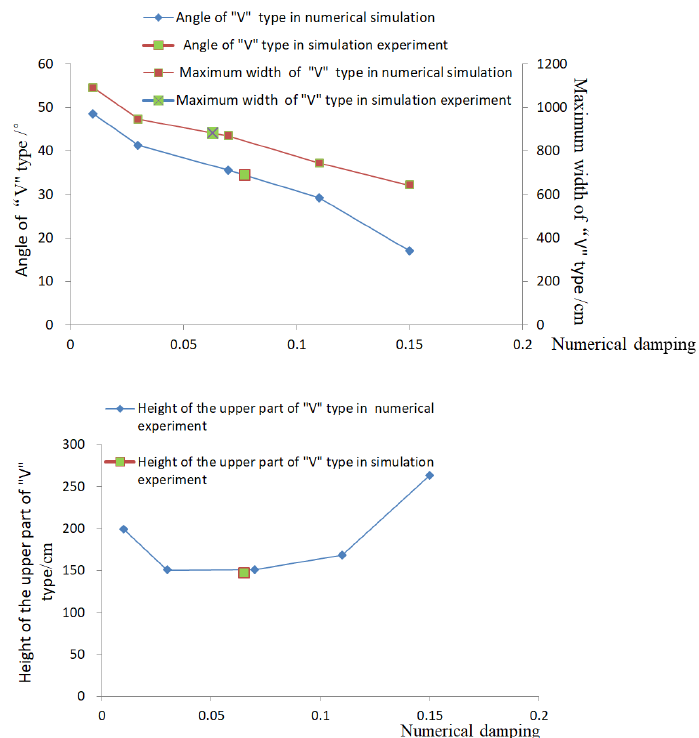
Figure 12. “V” type characteristics of coal drawing funnel of numerical simulation and simulation experiment after “large” caving.